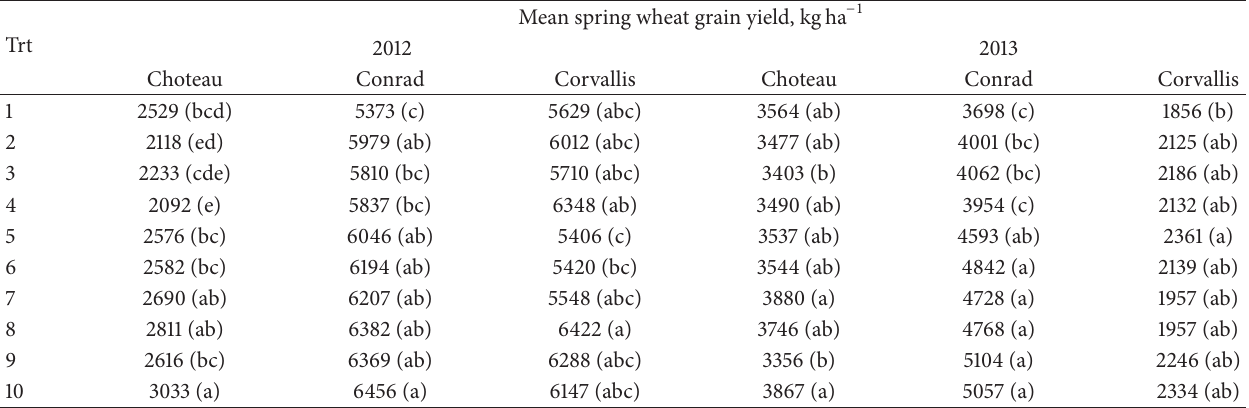
Table 4: Treatment structure, Choteau, Conrad, and Corvallis, 2012 and 2013.